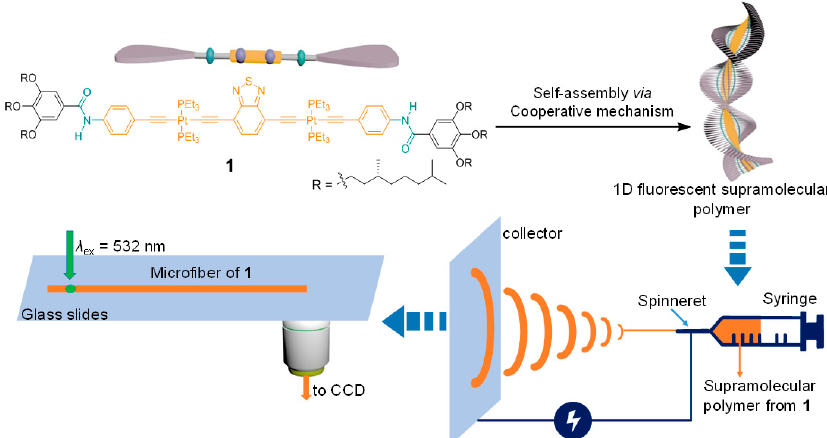
Figure 11. Diagram of “nucleation-chain growth” synergistic supramolecular polymerization system and its optical waveguide application (ex is shorted for the excitation light, λ ex is referred to the wavelength of the excitation light, the whole Figure 11 was reprinted with permission from Wang et al. [51]).